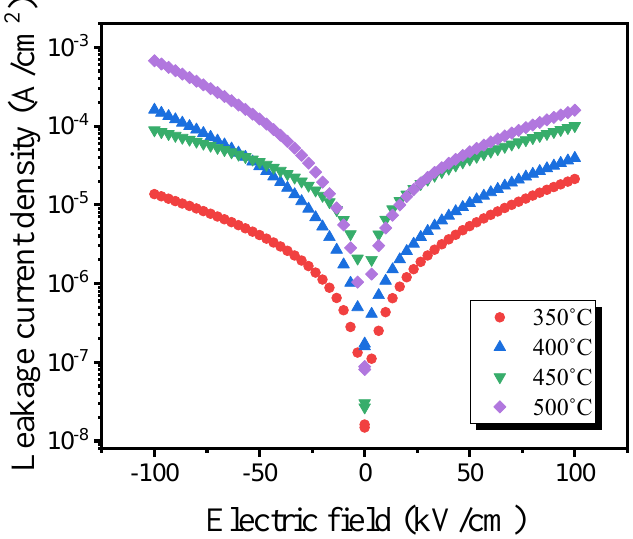
Figure 8. Leakage current density of Bi 0.9 Gd 0.1 FeO 3 ( T g = 350, 400, 450, and 500 °C) films. Additionally, the magnetic properties of Bi 1 − x Gd x FeO 3 films are investigated, too. Their M - H curves are depicted in Figure 9. All BGFO films exhibit ferromagnetic behavior and exhibit enhanced magnetic properties. The saturation magnetization ( M s ) increases dramatically from 4.9 to 23.9 emu/cm 3 , but the magnetic coercive field ( H c ) drops from 502 to 350 Oe as the Gd content increases from 0.00 to 0.15. The magnetization enhancement due to Gd substitution is presumably related to the distorted Fe-O-Fe bond, influencing the Fe-O-Fe exchange way, and the magnetic moment of Gd 3+ ion